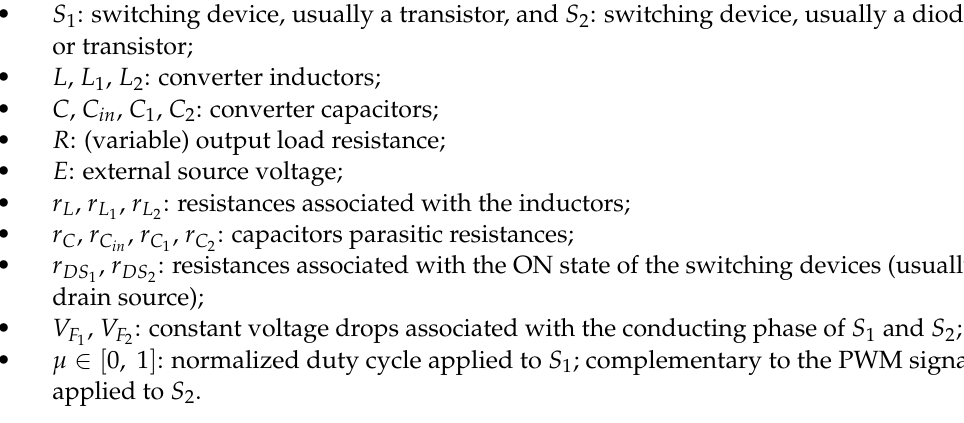
Figure 7. DC-to-DC power converter circuit topologies considered in the case studies: step-down (buck), step-up (boost), and single-ended primary-inductor